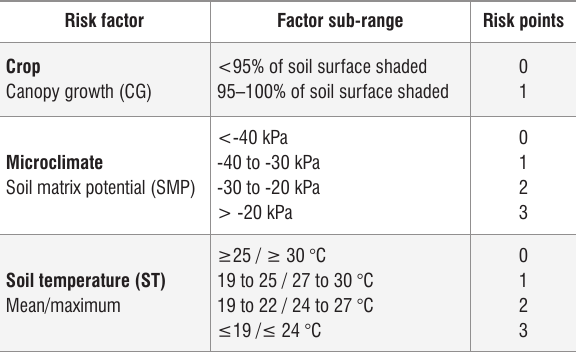
Disease incidence in last host crop